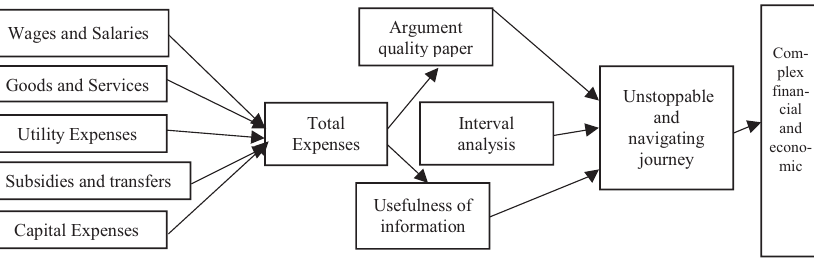
Figure 3. Conceptual framework (source by the